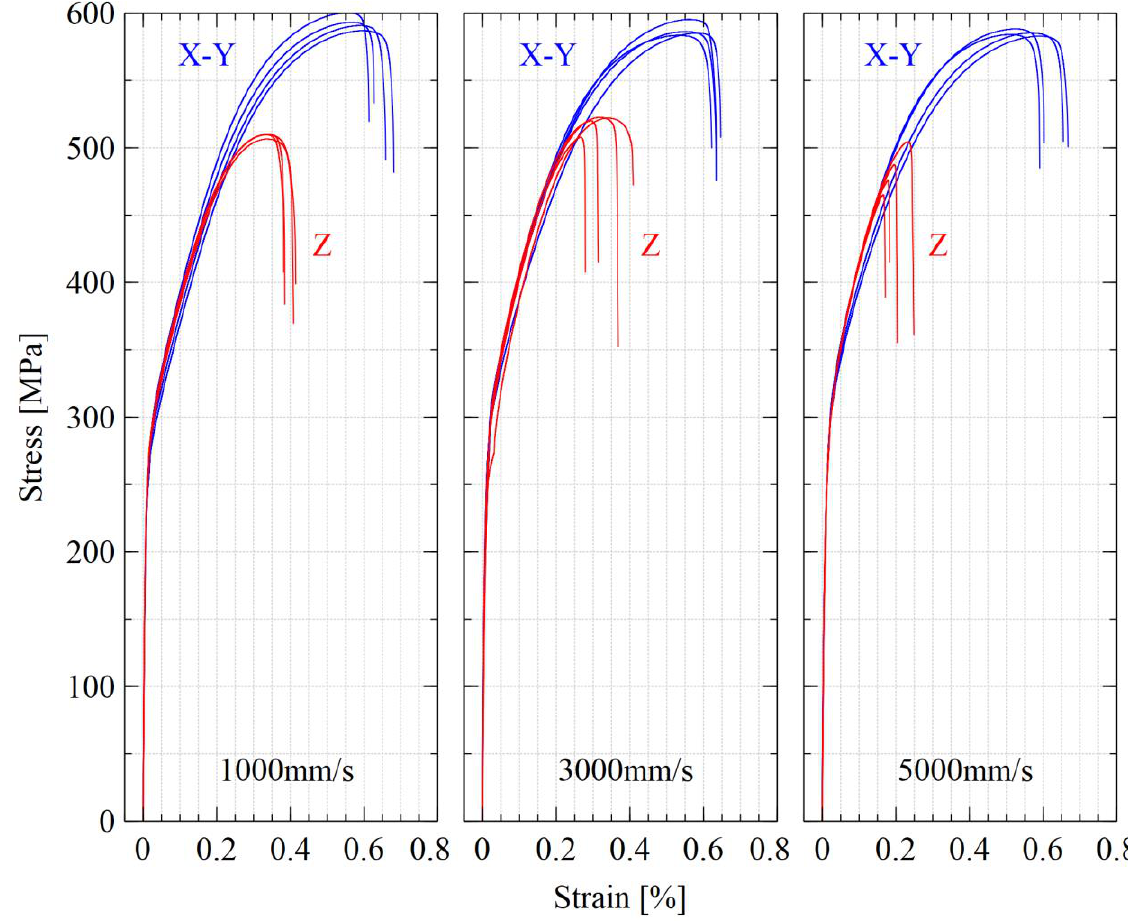
Figure 6. Results from tensile testing of EBM-processed 316LN stainless steel. All of the xy -oriented tensile bars exceeded the specifications for both cast and wrought 316LN described by the ASTM standards ASTM240 (cast), ASTM A276